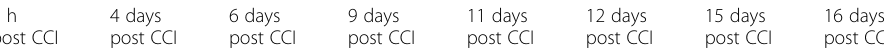
Table 1 Time steps of local field potential (LFP) and spike train analysis (STA) data recording from two brain regions (primary somatosensory cortex, S1, and ventral posterolateral nuclei of thalamus, VPL) of adult rat, after chronic constriction injury (CCI) surgery of the sciatic nerve 3 h post